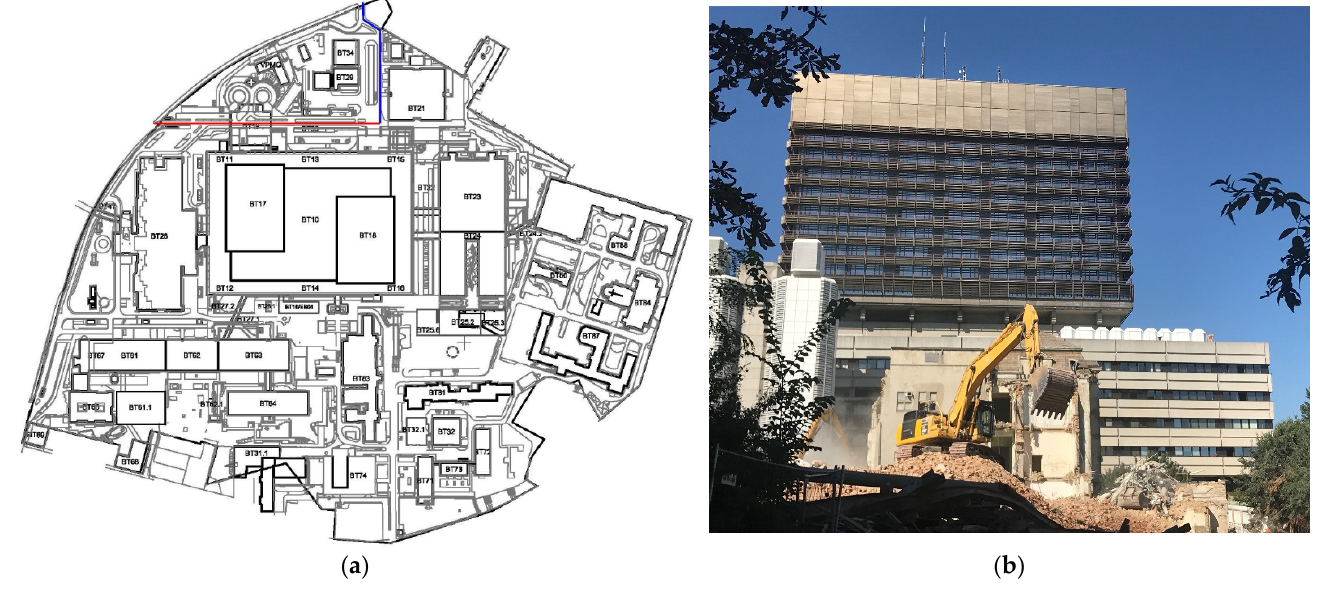
Figure 1. ( a ) Ground plan of VGH, ( b ) photo of demolition site, BT = building.